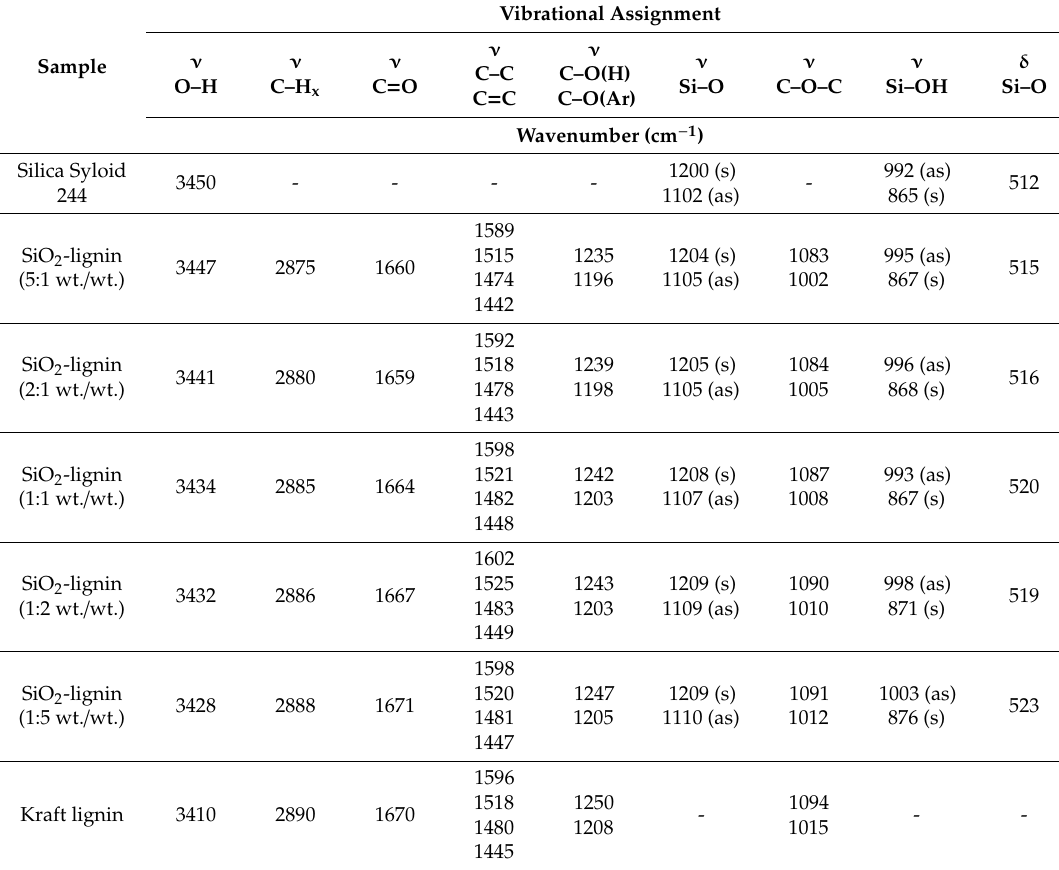
Table 2. Vibrational frequency wavenumbers (cm − 1 ) for silica, lignin and silica-lignin hybrid materials with di ff erent weight ratios of the components